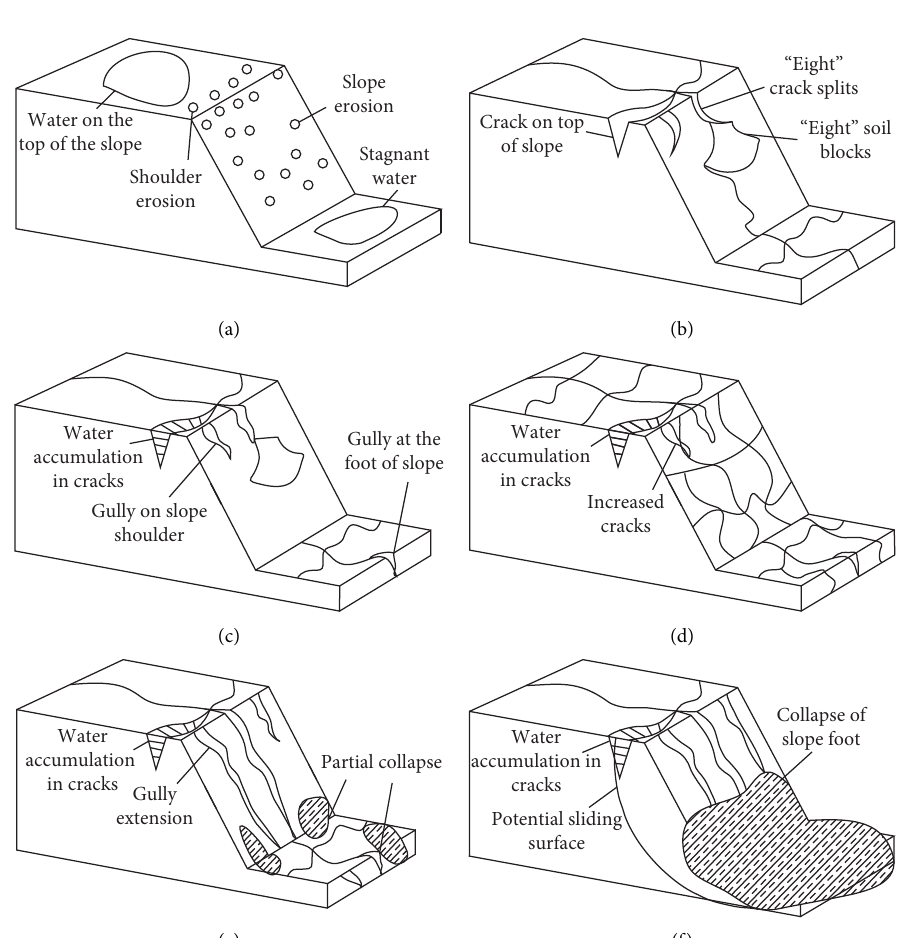
Figure 13: Slope failure evolution law under dry-wet cycle. (a) Sputter erosion and surface erosion stages. (b) Fracture development stage. (c) Gully formation stage. (d) The development of the gully through stage. (e) Partial collapse stage. (f) The collapse stage of the slope